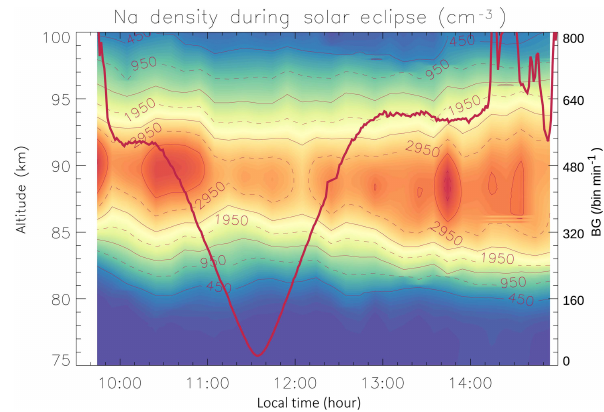
Figure 4. The mesospheric Na density variation during the so- lar eclipse on 21 August 2017, observed by the Na lidar at Utah State University. The red solid line represents the lidar-detected sky background. The unit for the lidar background measurement is bin − 1 min − 1